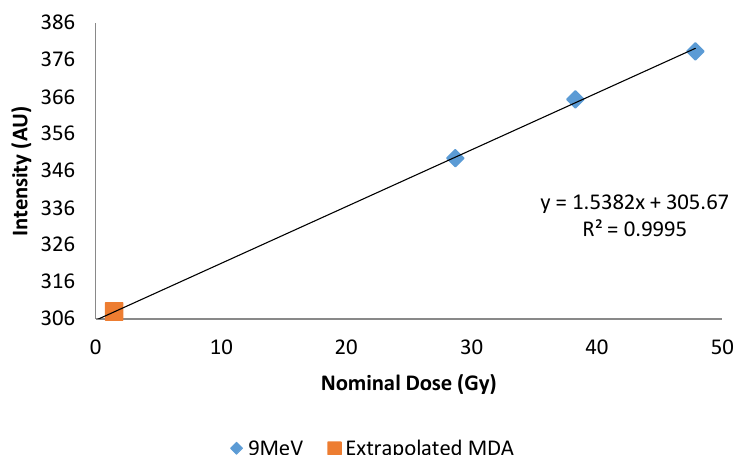
Figure 7. Plot of 9 MeV dose response plotted with extrapolated MDA. X -axis represents central axis dose for the depth of cuvettes. Y -axis is the normalized fluorescent intensity.